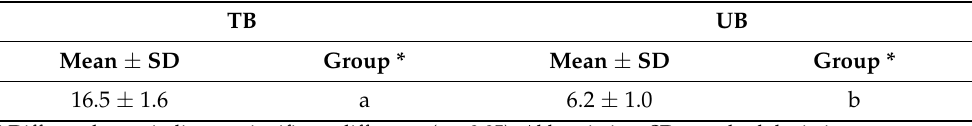
Table 3. KHN for different orthodontic adhesive pastes.